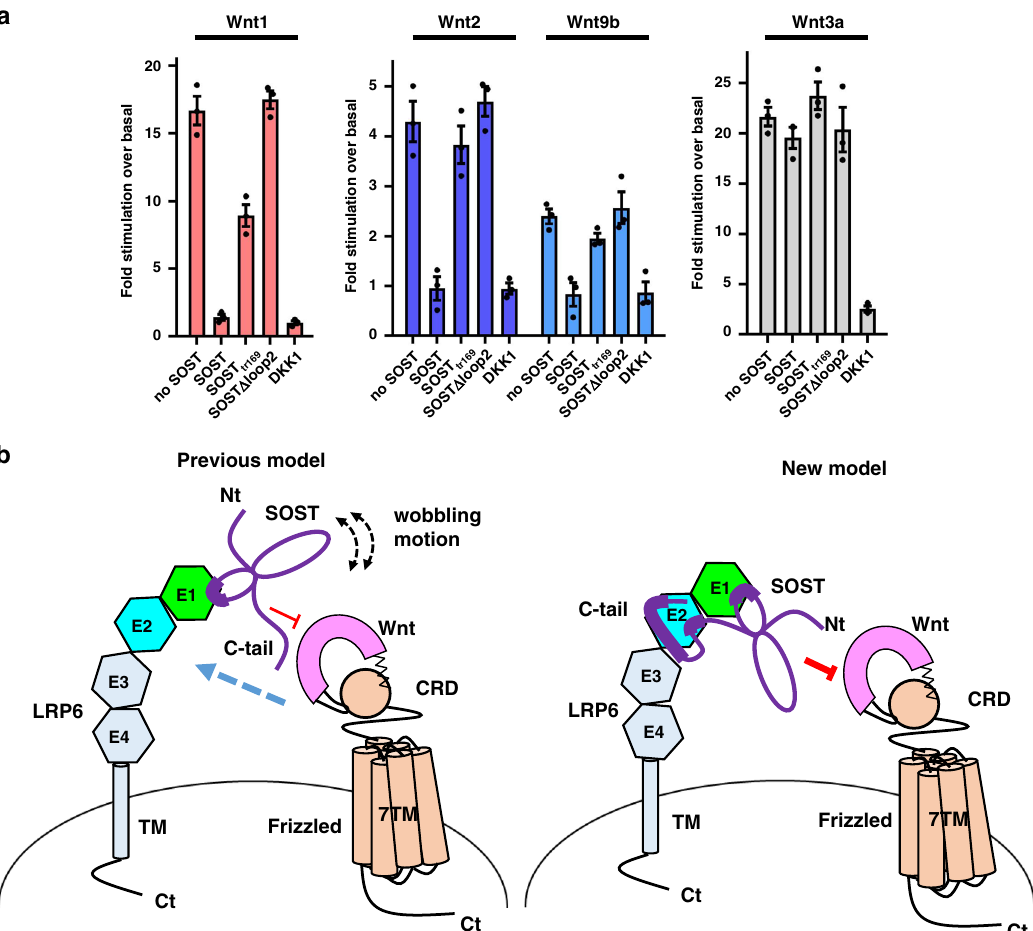
Fig. 6 Proposed mechanism whereby SOST inhibits Wnt signaling. The inhibitory effects of WT SOST and SOST mutants on Wnt signaling activated by Wnt1, Wnt2, Wnt9b, and Wnt3a were measured by TopFlash assays. Full-length DKK1 was also used in the activity assays for comparison with SOST. Data from three independent experiments ( n = 3) were analyzed and expressed as mean ± SEM. b A schematic model of the mechanism whereby SOST inhibits the canonical Wnt signaling pathway. In a previous model (left), only the loop 2 region of SOST was suggested to interact with the LRP6 E1 domain, which appears to inef fi ciently inhibit the binding of various Wnt subtypes. The double-headed arrows indicate the wobbling motion of SOST, owing to fl exibility in the loop 2 region. On the other hand, the structural and functional data presented here suggest that the C-terminal HNQS region of SOST binds to LRP6 E2, and that the basic cluster region in the far C-terminus of SOST may further strengthen the interaction with the E2 domain. Based on the SOST C-tail- mediated interaction with E2, we propose a new binding model for SOST (right). In this model, tandem interaction of SOST with LRP6 E1 and E2 leads to more ef fi cient blockage of Wnt